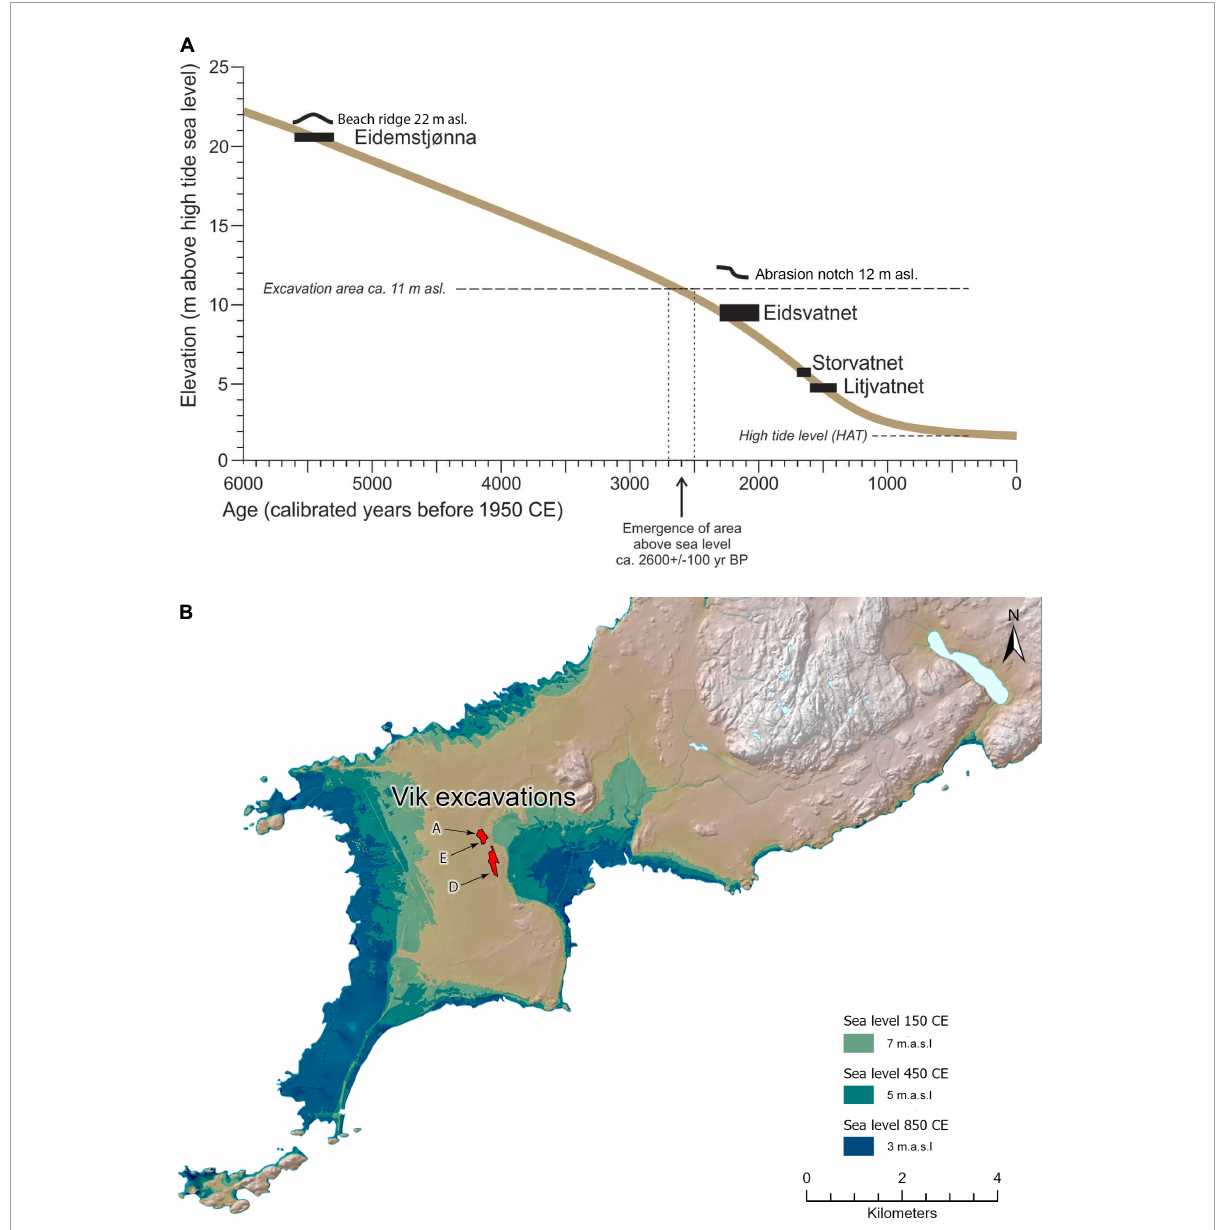
FIGURE2 Shoreline changes at Ørland through time. (A) The new shoreline displacement curve for the period 6,000 calibrated years BP to present, (B) the shoreline at Ørland in different settlement phases, with the excavated areas at Vik marked. In-context pollen samples are analyzed from areas A, D, and E. Illustration: Magnar Mojaren Gran, NTNU University